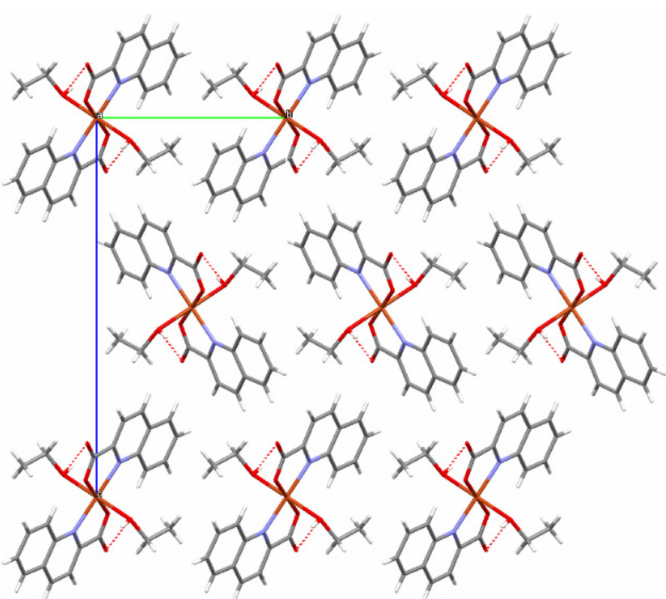
Figure 3. A projection of the structure along a -axis showing the packing of